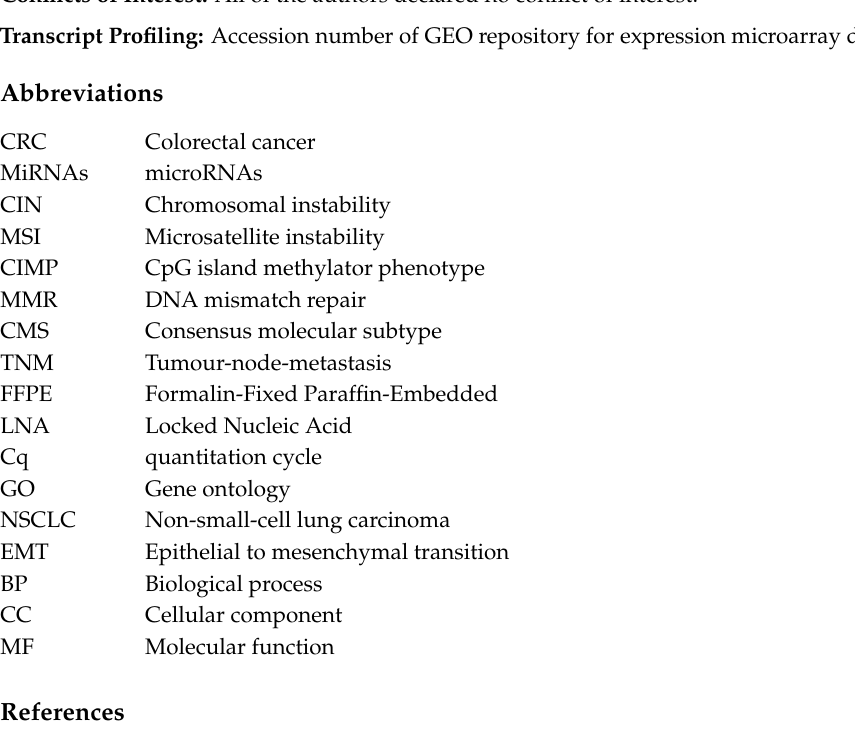
Figure S1: Functional enrichment analysis of miRNAs associated with age and Lynch syndrome, Figure S2: Functional enrichment analysis of miRNAs associated with biopsy histopathological features, Figure S3: Functional enrichment analysis of miRNAs associated with tumour invasion and